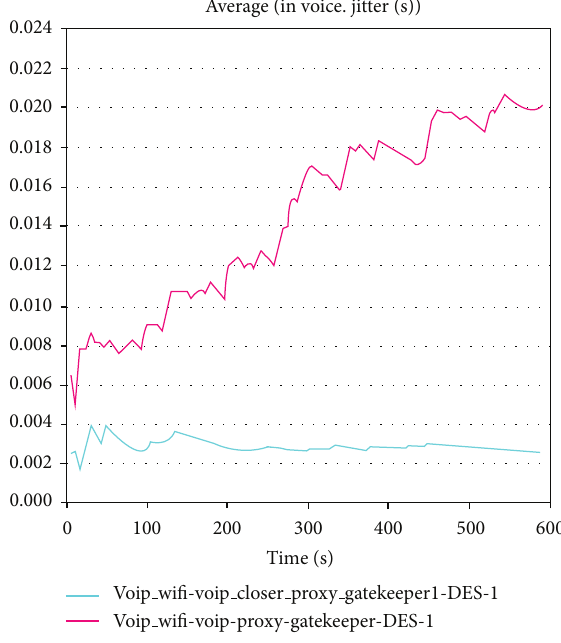
Figure 4: Wireless scenario with the new crated device.